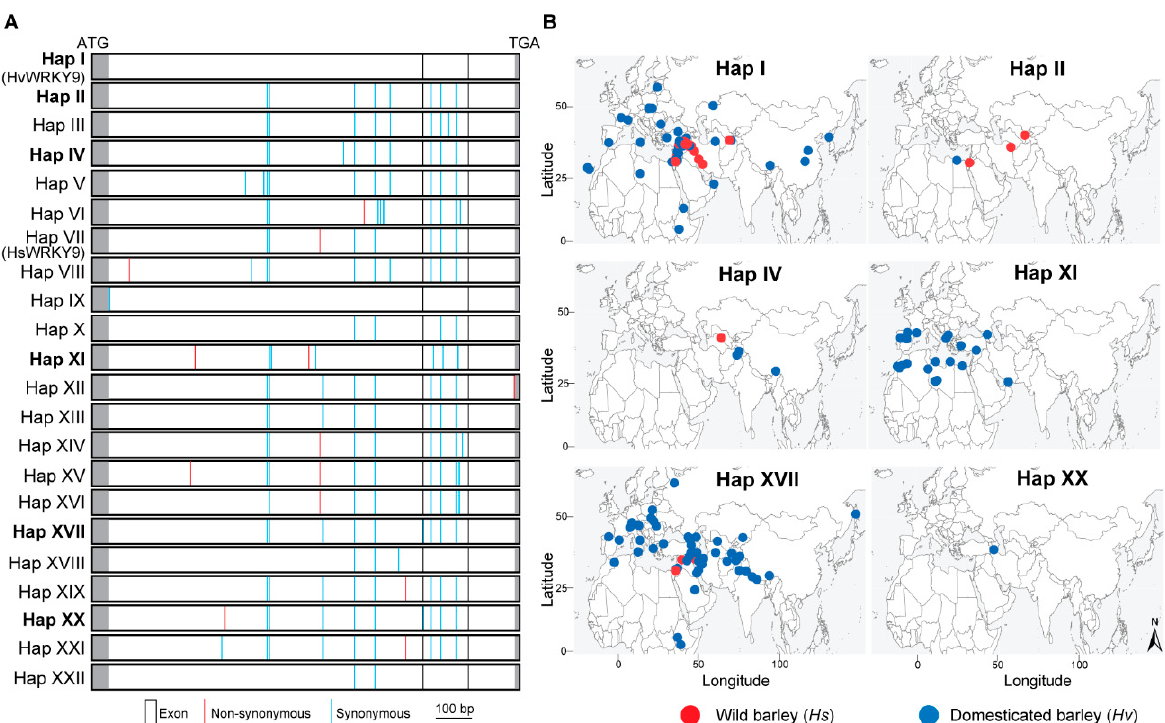
Figure 4. Haplotypes of WRKY9 and their geographical distribution. ( A ) Graphical representation of full-length coding region in each haplotype. The non-synonymous and synonymous substitutions if compared to Hap I ( HvWRKY9 ) were indicated using red and blue lines. Hap VII showed a sequence identical to HsWRKY9 identified from the reference assembly of wild barley ‘AWCS276’. The bold-highlighted haplotypes were detected in cultivated barley. The red and blue lines indicated non-synonymous and synonymous, respectively. The rectangles represent the coding region of each haplotype, while the grey box indicates the part without qualified sequences. ( B ) Geographical distribution of barley accessions harboring respective haplotypes. Each accession is allocated according to latitude and longitude coordinates of its collection site. The red and blue circles indicate the wild and cultivated barley accessions, respectively.